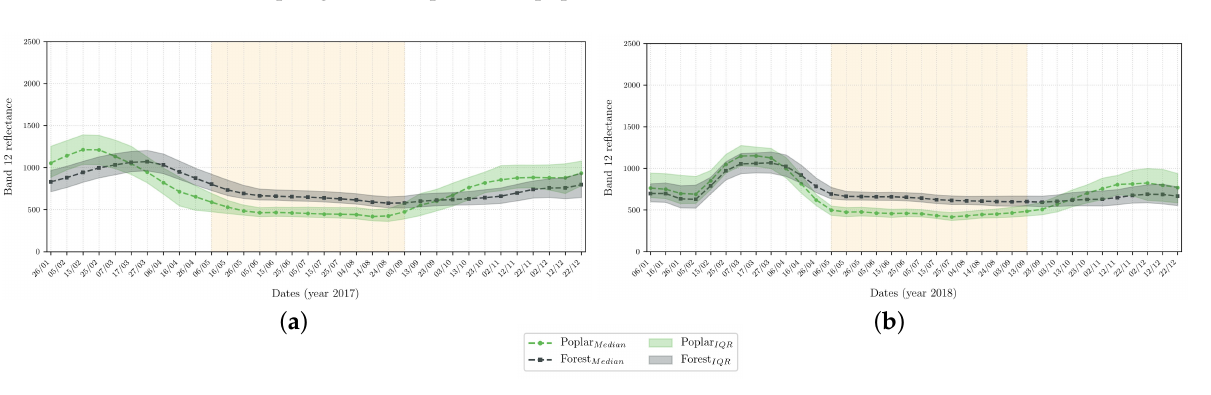
Figure A3. Temporal profile of band 5 reflectance in poplar plantations versus other deciduous tree species. In (a) the profile in 2017 and in (b) the profile in 2018. Dashed lines refer to the median signal and the surrounding shaded areas represent the interquartile range, shown in red for poplar and in grey for other deciduous species. The light yellow box highlights the most discriminating spring-summer period for poplars.